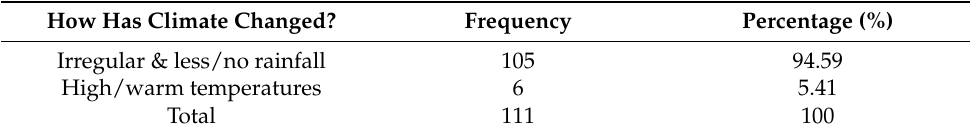
Table 1. Perceptions of Climate Change in the Bongo.